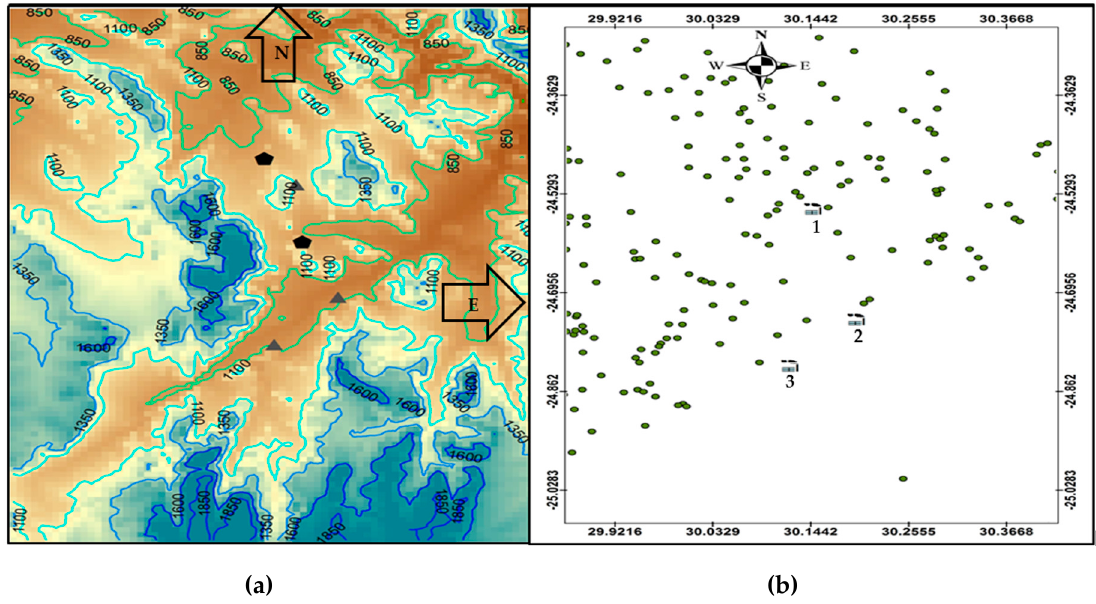
Figure 1. ( a ) Terrain map of the study area showing smelters as black triangles and mine tailings as black pentagons. ( b ) Study area showing location of smelters (1–3) and residential areas in green dots.